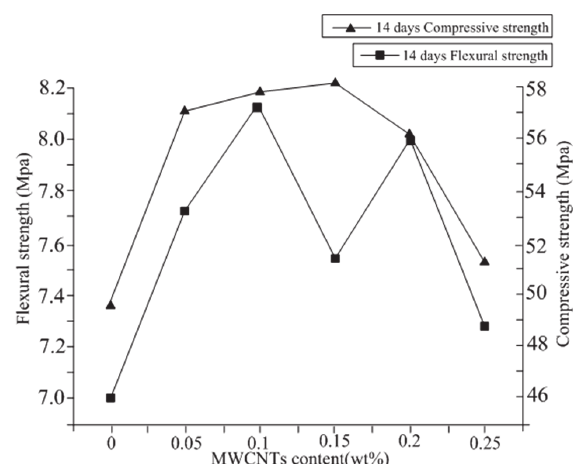
Figure 4: The mechanical properties of cement-based composite materials test specimens which were mixed with different amount of carbon nano-tubes after 14 days of maintenance.